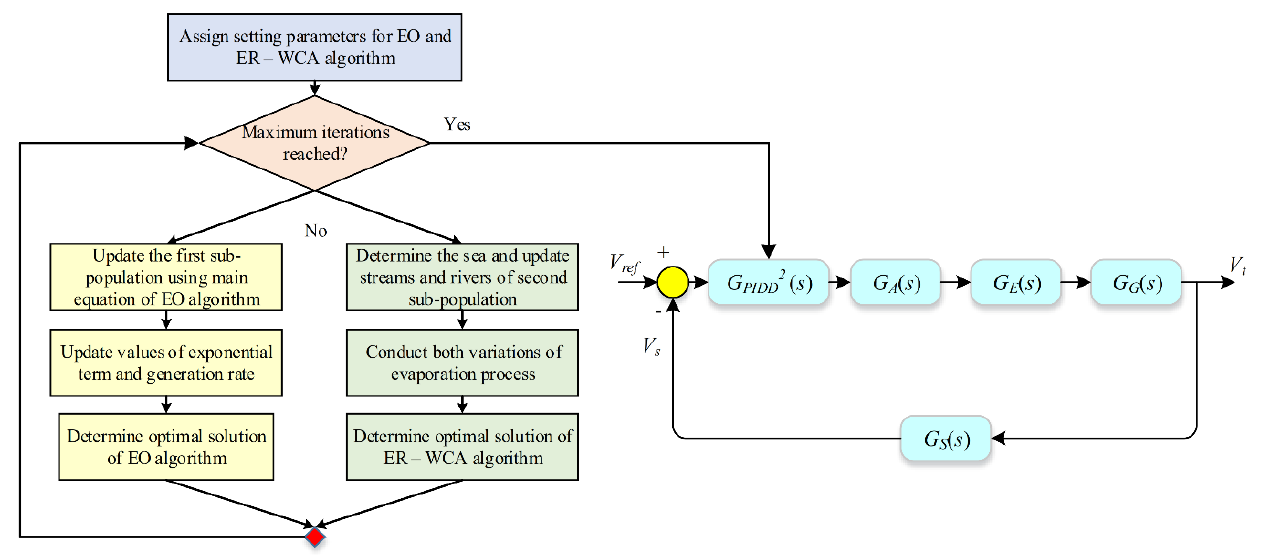
Figure 9. Flowchart of the EO–ERWCA algorithm.